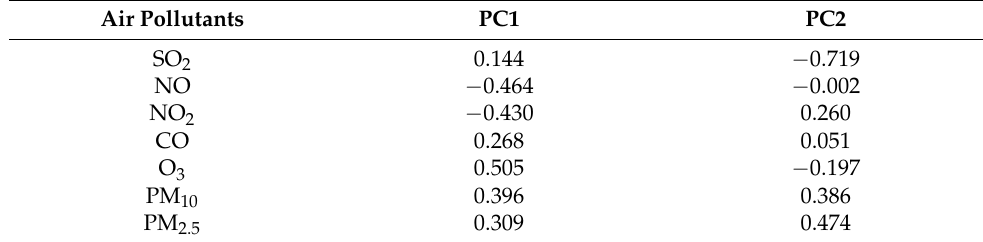
Table 2. Components loadings for air pollutant PC1 and PC2 after varimax